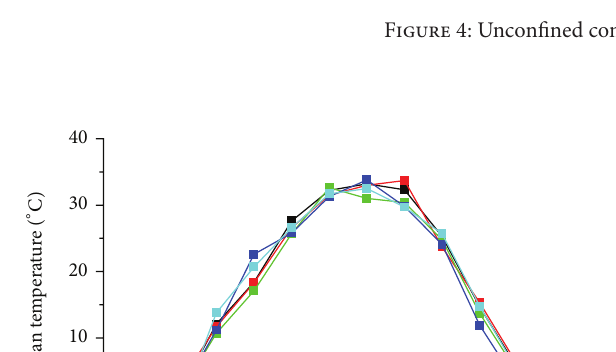
Figure 4: Unconfined compressive strength test results.